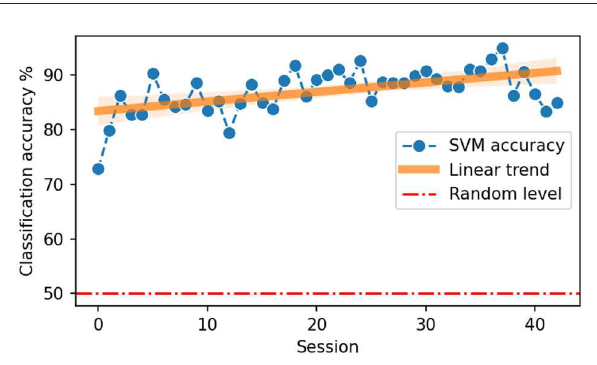
FIGURE5 Accuracy of left vs. right hand state classification using SVM classifier. The orange line indicates a linear trend fitted to the points.